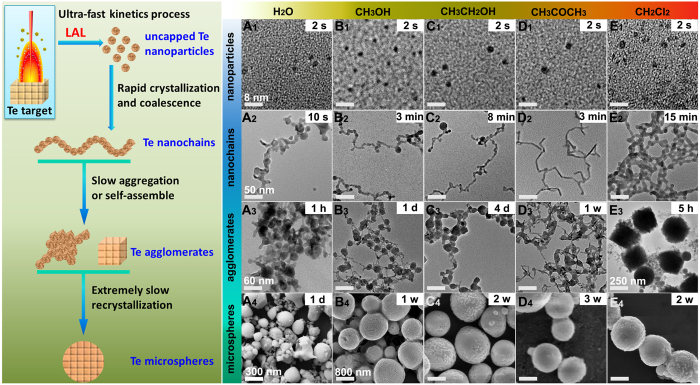
Schematic of spontaneous growth of uncapped Te NPs in various solvents and corresponding data on Te microstructures.TEM images of uncapped Te NPs (A1–E1), nanochains (A2–E2), and agglomerates (A3–E3). SEM images of microspheres (A4–E4) in five kinds of solvents, namely, H2O, CH3OH, CH3CH2OH, CH3COCH3, and CH2Cl2. Scale bar: 8 nm for A1–E1, 50 nm for A2–E2, 60 nm for A3–D3, 250 nm for E3, 300 nm for A4, and 800 nm for B4–E4. Time of taking sample to perform TEM characterization: 2 s for A1–E1; 10 s for A2, 3 min for B2 and D2, 8 min for C2, 15 min for E2; 1 h for A3, 1 day for B3, 4 days for C3, 1 week for D3, 5 h for E3; 1 day for A4, 1 week for B4, 2 weeks for C4 and E4, and 3 weeks for D4.